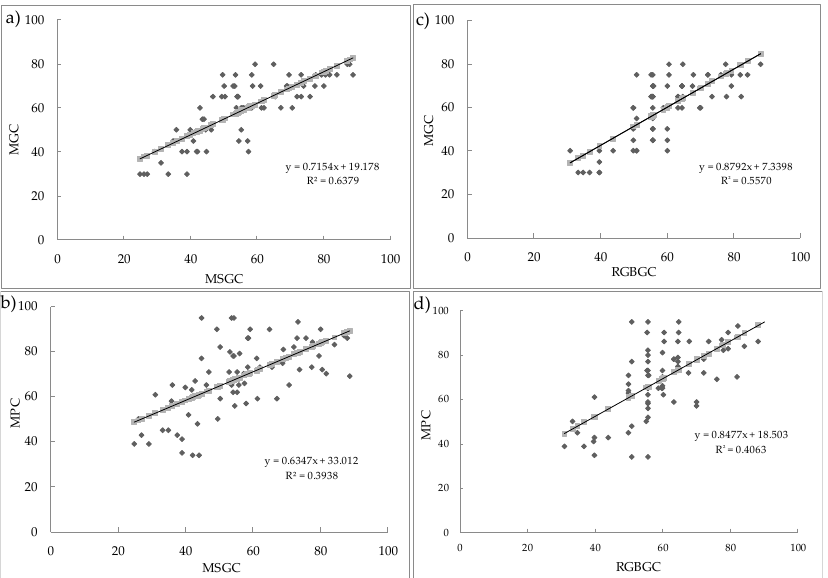
Figure 2. ( a ) Multispectral orthomosaic of the experimental site where Green, NIR, Red and Red edge multispectral bands converted to false colours composite to differentiate individual plots; ( b ) the ground cover classification map in eCognition software package where green represents perennial ryegrass ground cover; orange represents soil and weed cover within the experimental plot boundaries.